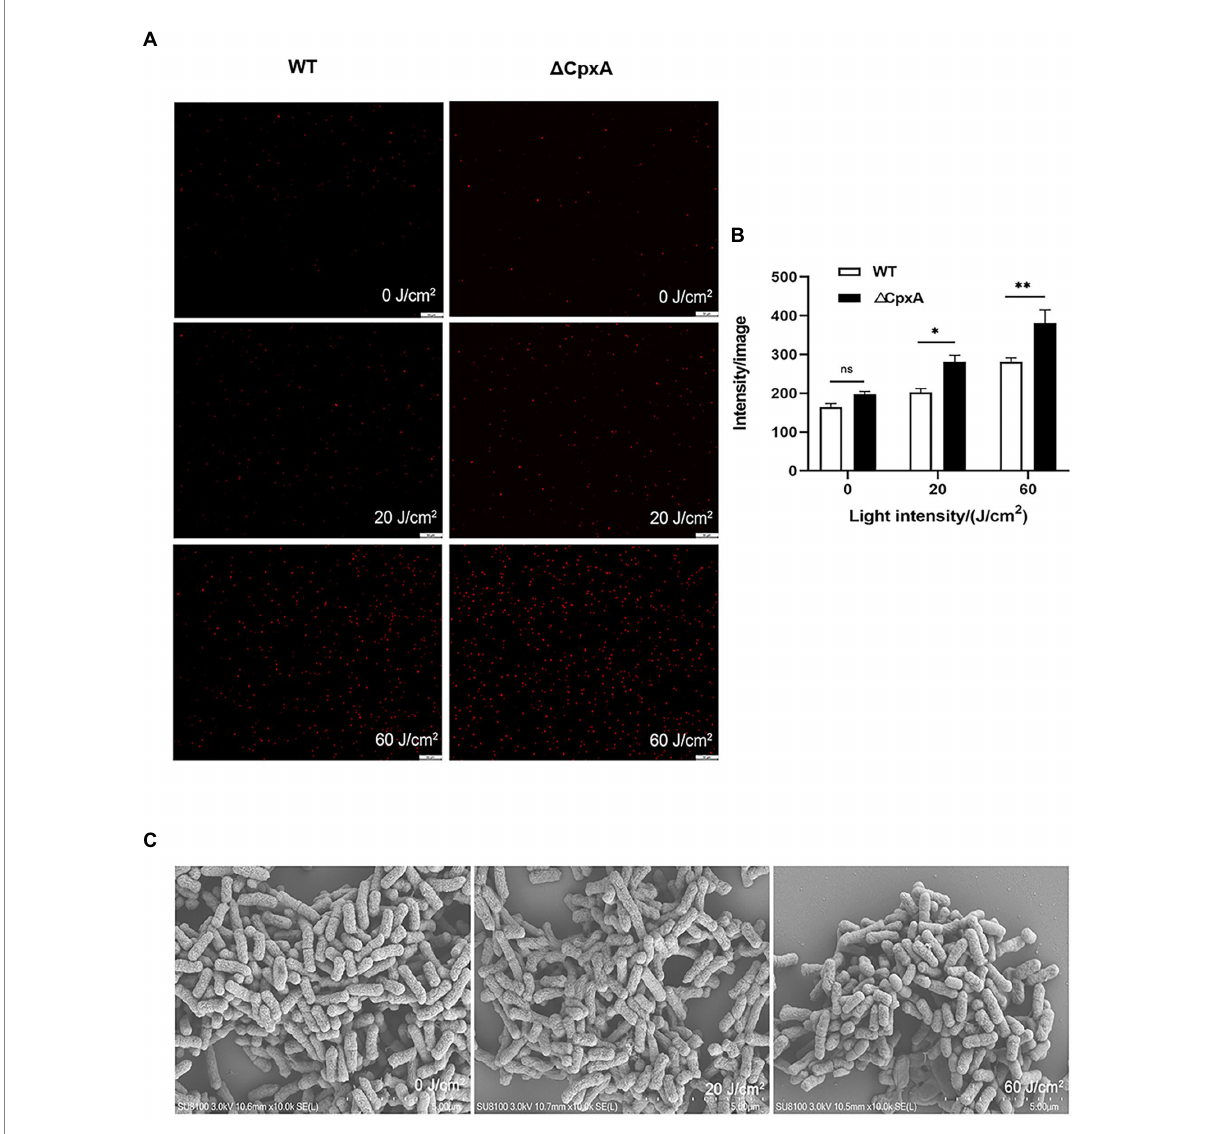
FIGURE 6 Effect of aPDI on the membrane integrity of Δ CpxA. The aPDI-treated wildtype and Δ CpxA were subjected to PI staining. Representative fluorescence microscopy images (A) , as well as their quantification (B) were shown in cells treated with 30 μ M HB photo-activated by various light doses (20 J/cm 2 , 60 J/cm 2 ). The scale bar represents 50 μ M. In addition, anatomical features of C. sakazakii were observed through SEM with a scale bar set as 1 μ m (C) . Values are the mean ± SEM (standard error of mean) from 4 replicates. * p < 0.05, ** p < 0.01, *** p < 0.001, ns, p >